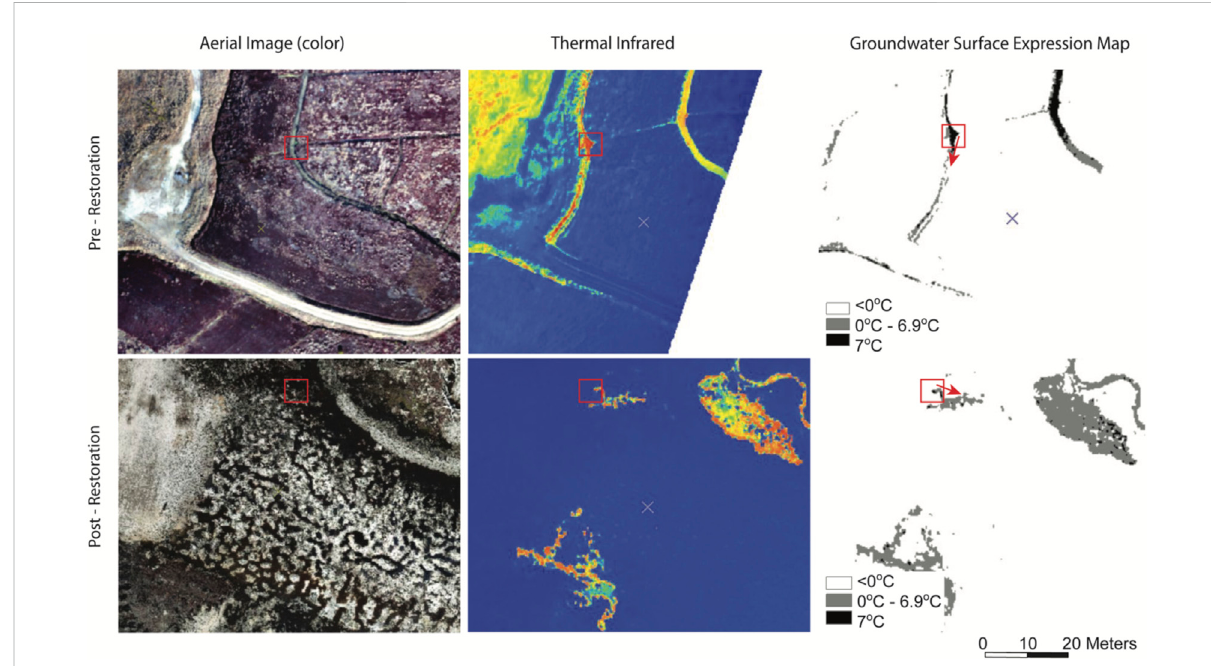
FIGURE 7 Comparative UAS imagery from pre-restoration (top row) to post-restoration at Foothills Preserve, from left to right: (left) plain light (RGB image), (center) thermal infrared, and (right) surface expression of groundwater (black = groundwater and gray = mixing zone). This fi gure shows an areawhere fl owingsprings discharged into ditchesand channels before restoration. During restoration, themain channelwas fi lled in,thebermwas removed, and the surface was broken up and mixed to create microtopography. Springs located in this area grow into seep complexes after restoration, rather than having their geometry controlled by farm ditch structures. The seep direction changes from fl owing south (pre-) to fl owing east (post-restoration). The red arrows indicate fl ow